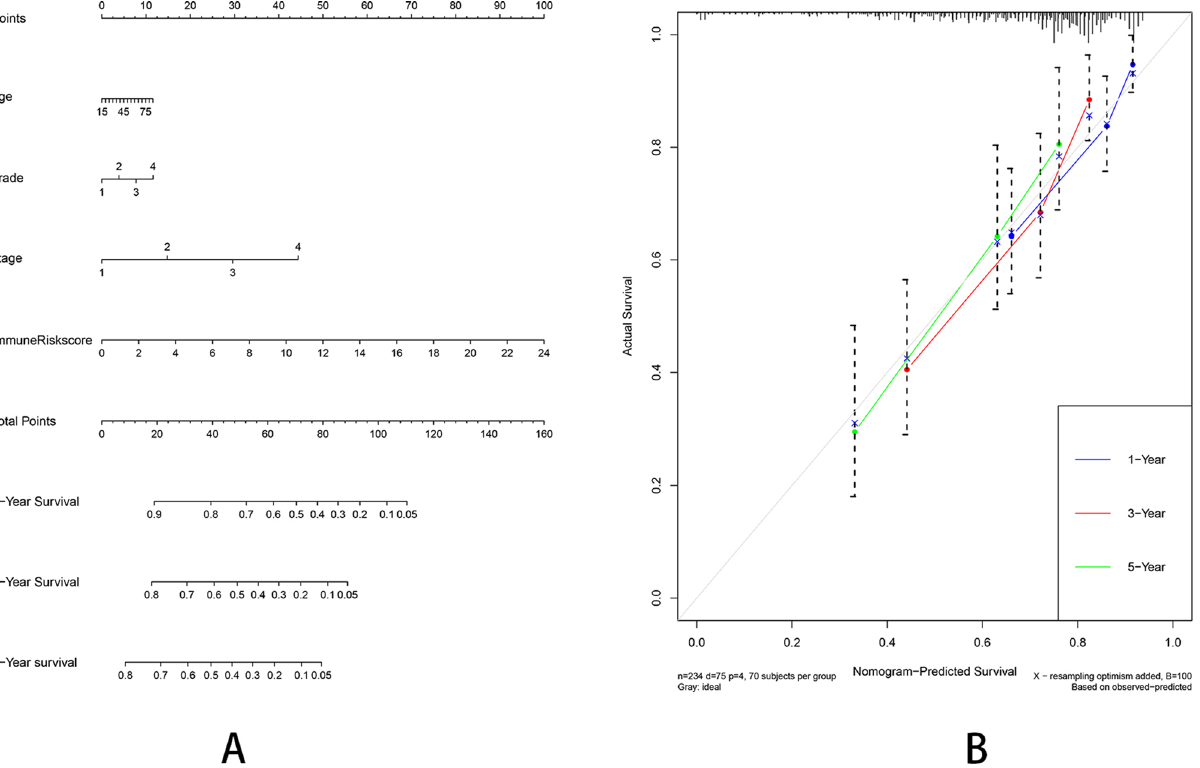
Figure 7. (A) A prognostic nomogram including Immune-Risk score and other clinical factors. (B) The calibration plot comparing predicted and actual 1-, 3-, 5-year overall survival. The graph relative to the 45 diagonal reveals the model relative to perfect